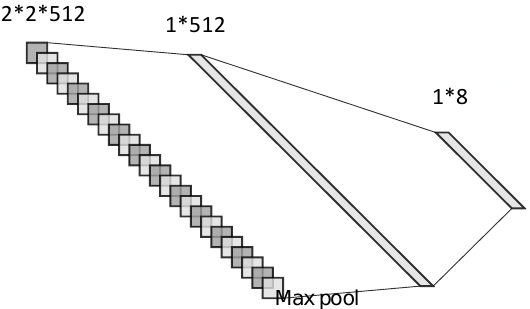
Figure 8. The structure diagram of dimensionality reduction and classification layers.